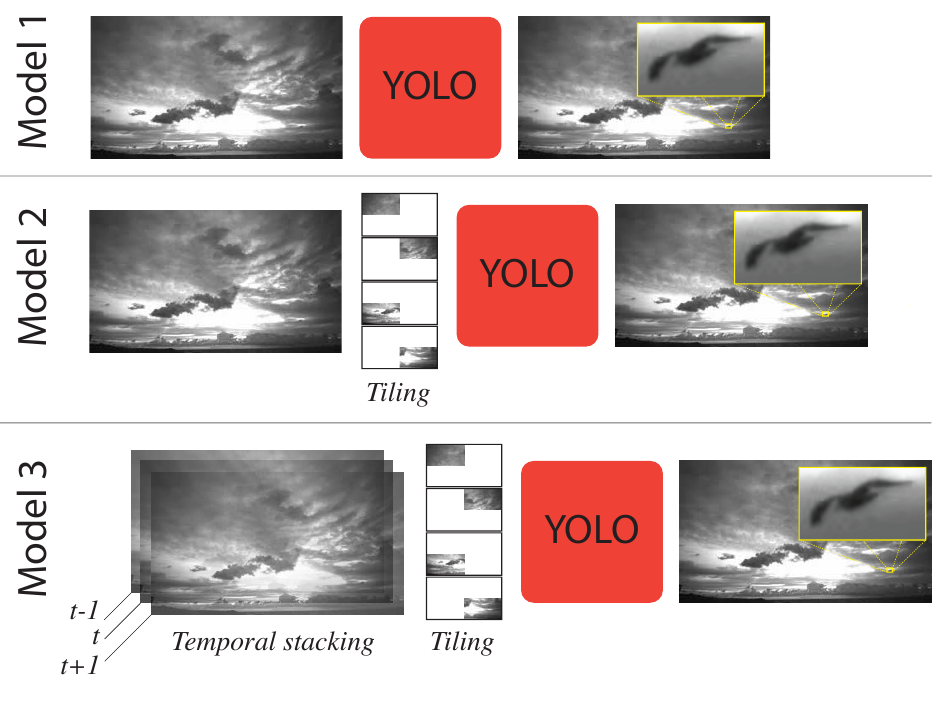
Figure 3. Three YOLOv4 based models, each trained on the Klim dataset, for bird detection around wind